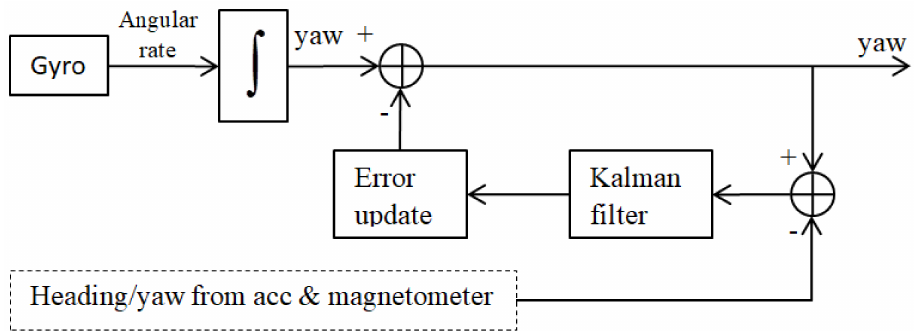
Figure 5. Structure of the Kalman-filter-based position estimation algorithm.